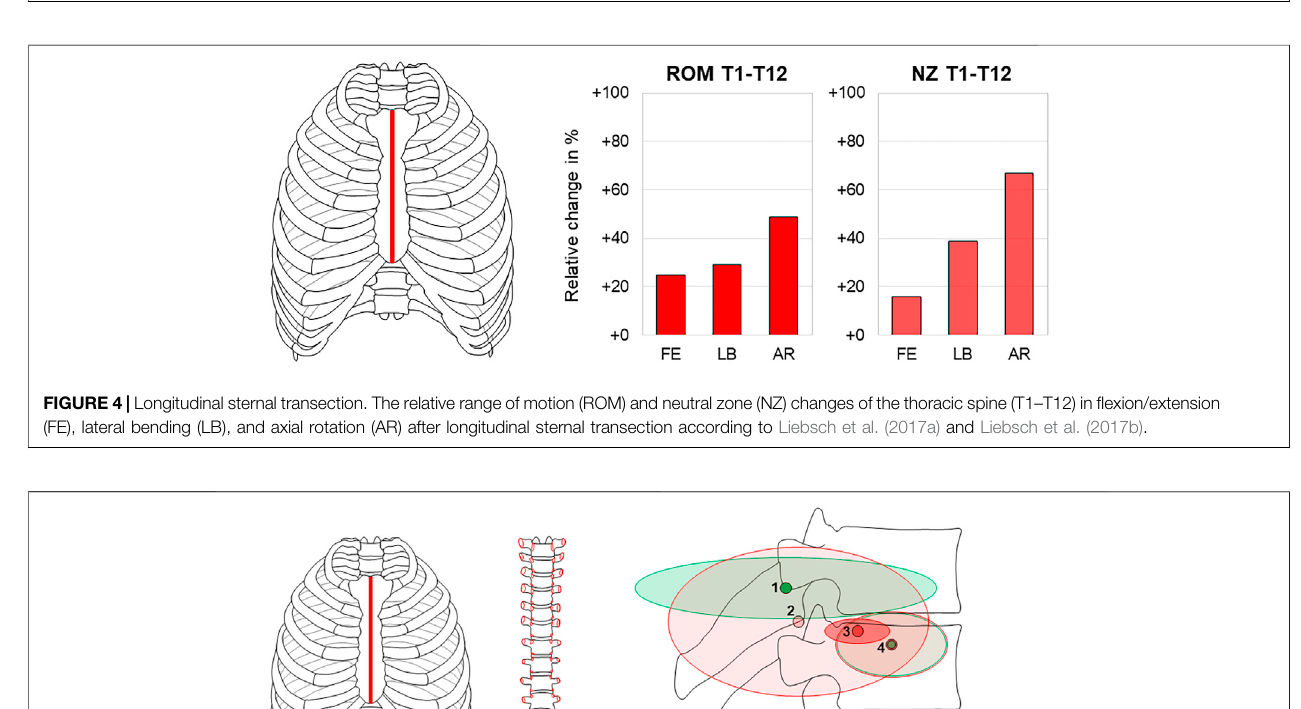
FIGURE 3 | Intercostal muscle removal. The relative range of motion (ROM) and neutral zone (NZ) changes of the thoracic spine (T1 – T12) in fl exion/extension (FE), lateral bending (LB), and axial rotation (AR) after intercostal muscle removal according to Liebsch et al. (2017a).